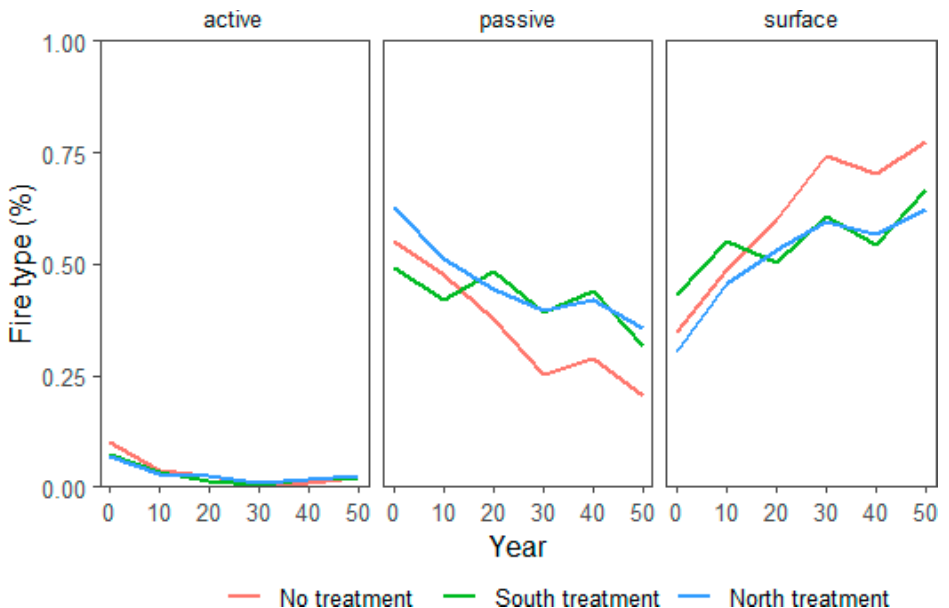
of simulated forest growth.